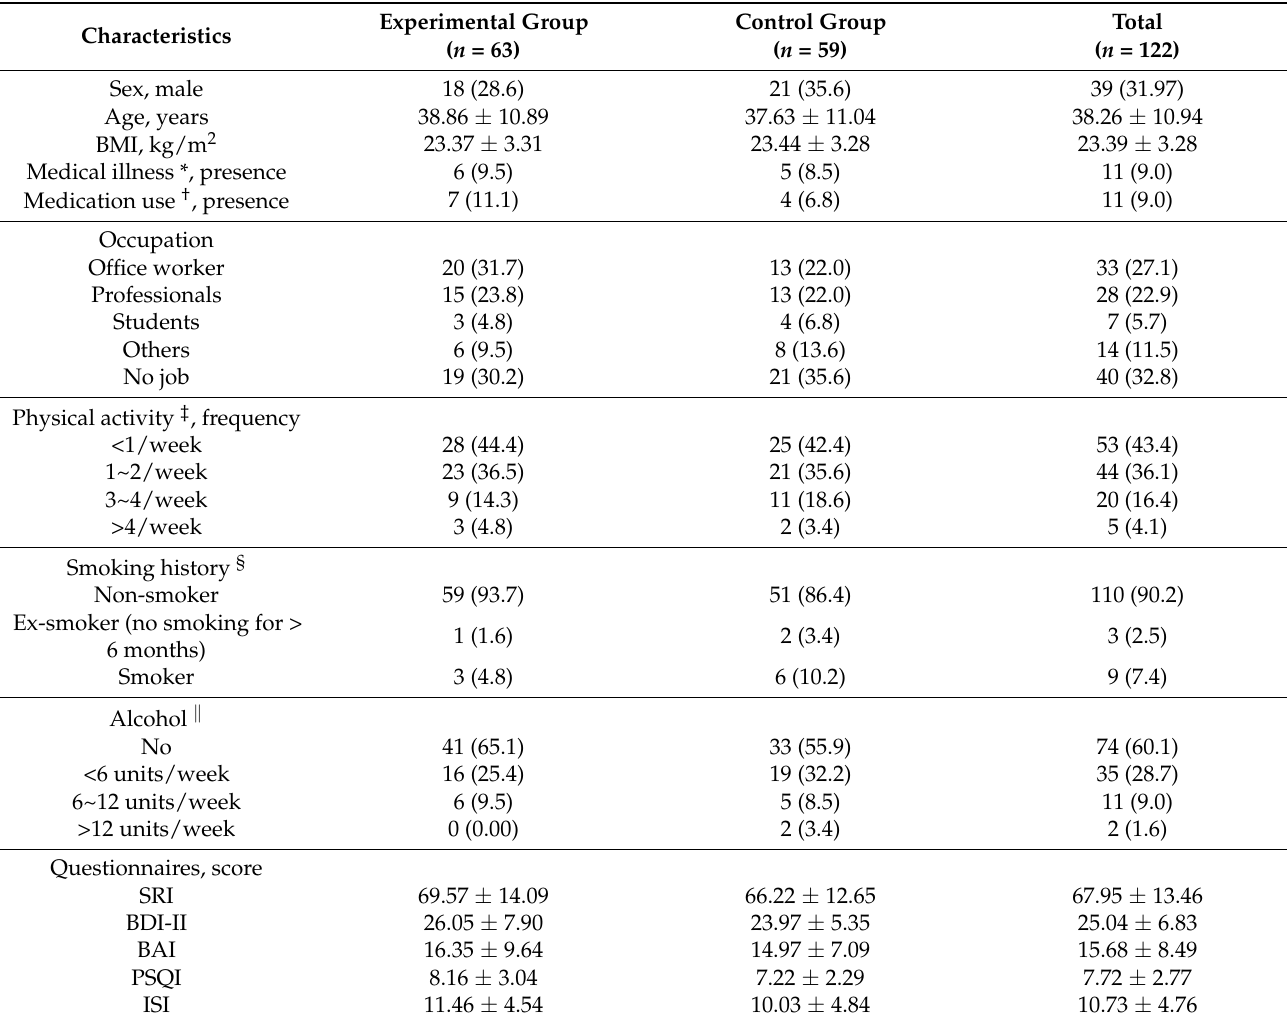
Table 1. Baseline demographic and clinical characteristics of study